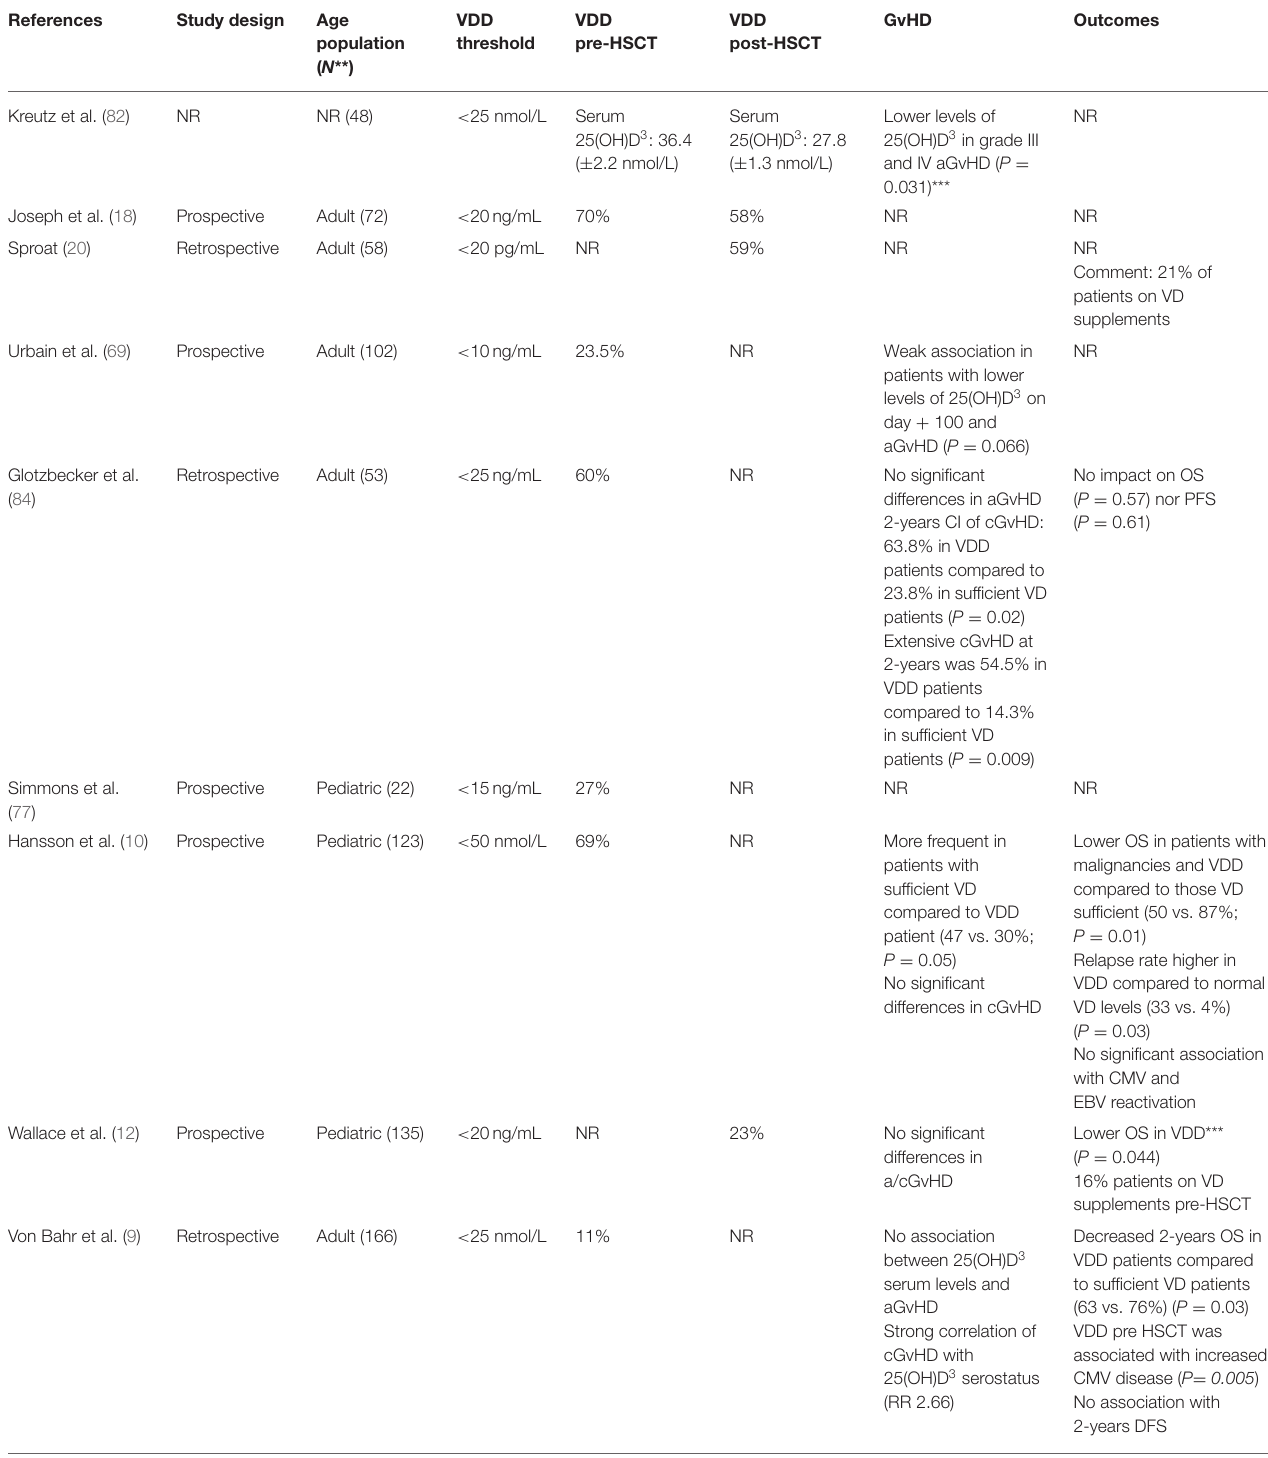
TABLE 1 | Observational studies correlating vitamin D status with outcome